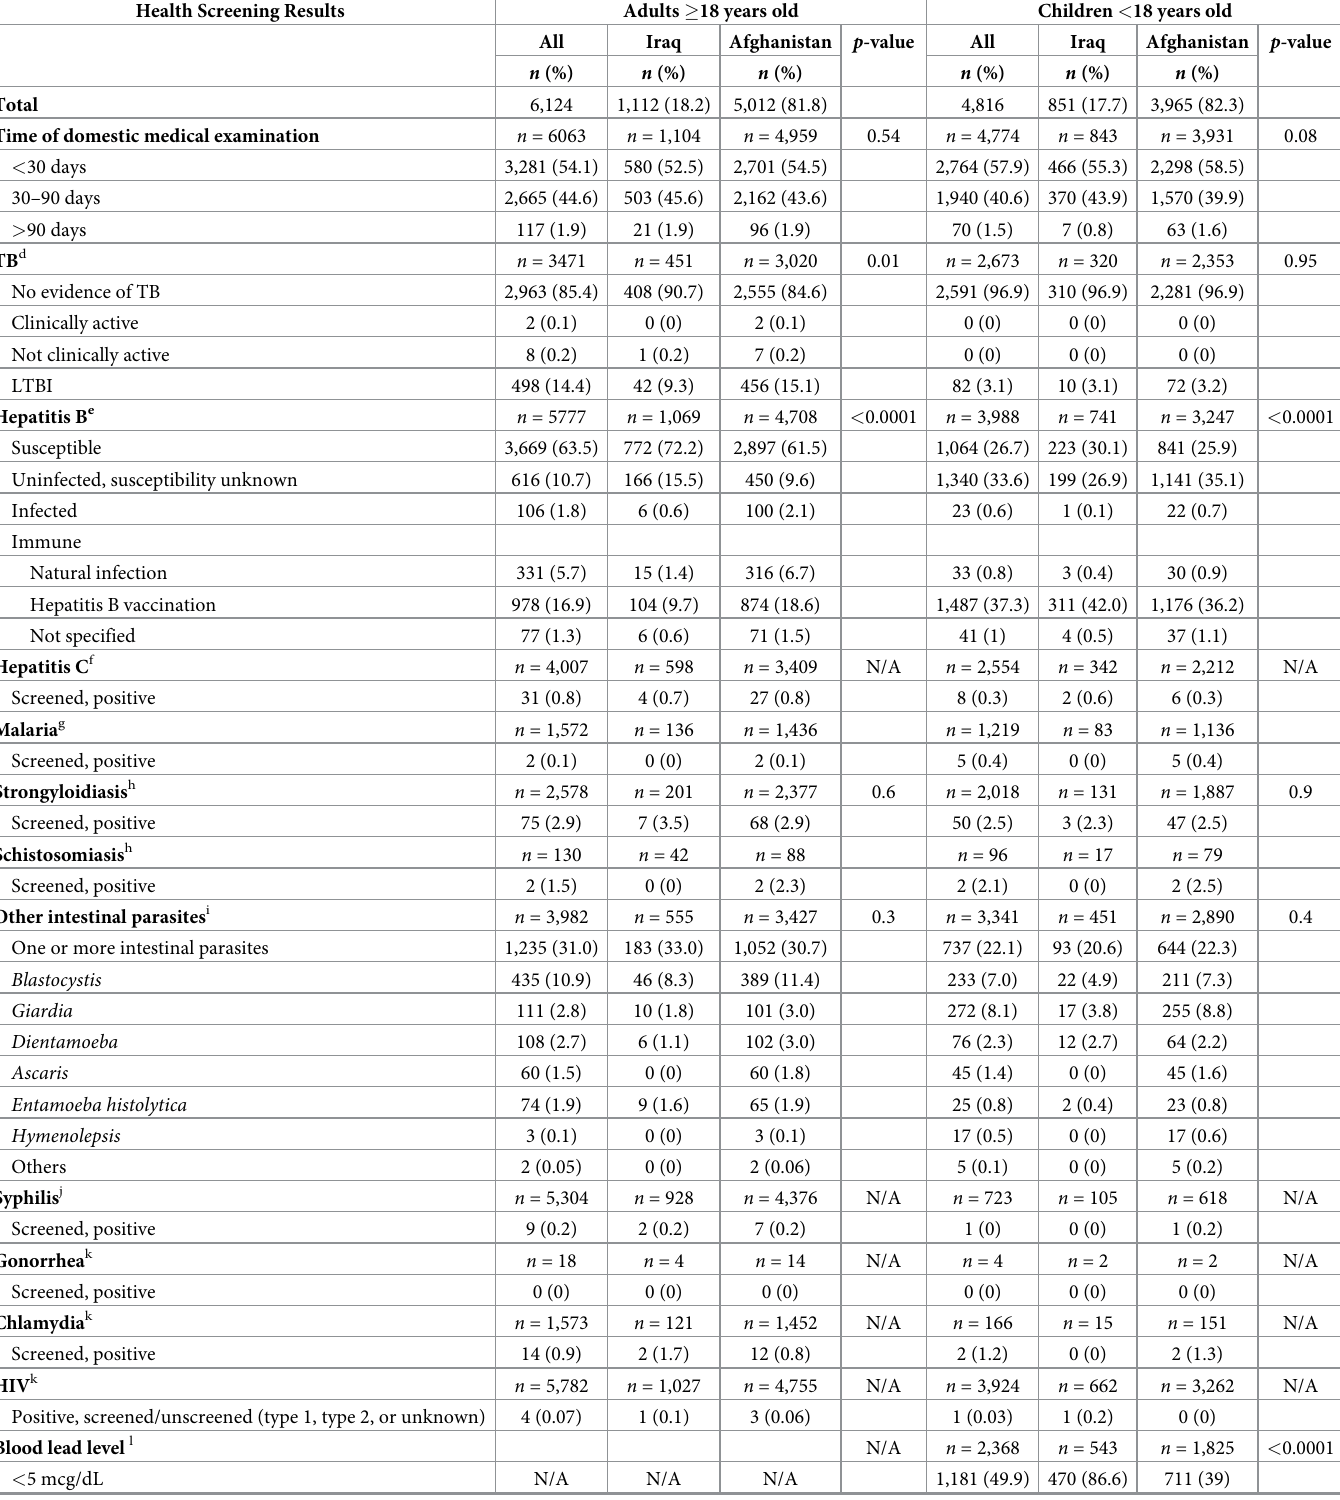
Table 2. Domestic health screening results among adults and children who resettled to the US with Special Immigrant Visas (SIV), 2014–2016 a,b,c